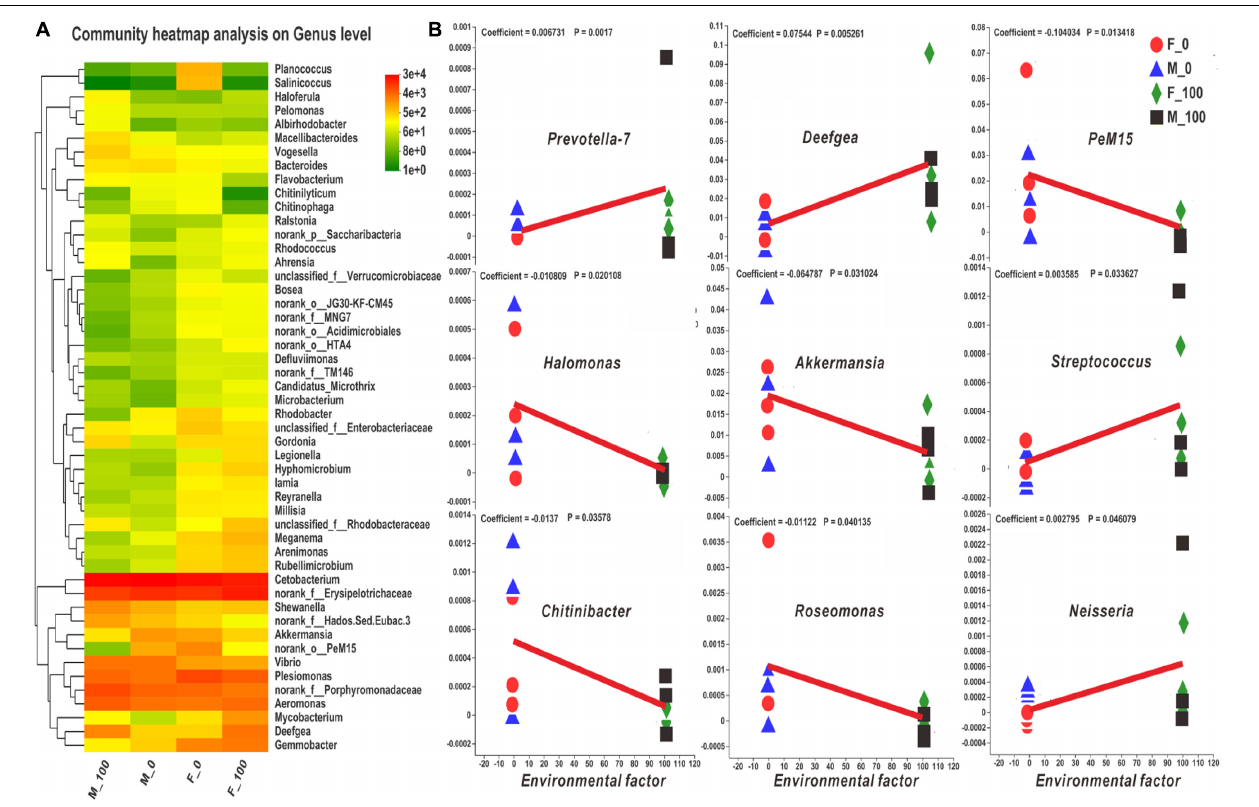
FIGURE 3 | The heatmap and MaAsLin analysis of zebrafish intestinal bacteria according to the level of genus. (A) The bacterial hierarchical genera were clustered by the average manner, and the top 50 genera shown in the map were calculated by the log value of bacterial abundance in each group. (B) In the MaAsLin analysis of top 100 genera, the abundance of Prevotella-7 , Deefgea , PeM15 , Halomonas , Akkermansia , Streptococcus , Chitinibacter , Roseomonas , and Neisseria genera (B) were significantly related to the environmental factor of DEHP exposure with p < 0.05. In the heatmap, the X and Y axes are groups and genera with the cluster tree on the left, and the scale shown on the right side is the color range of different abundance values. In the MaAsLin legend, the X-axis means the relative abundance of each genus, and Y-axis indicates the environmental factor of DEHP exposure.